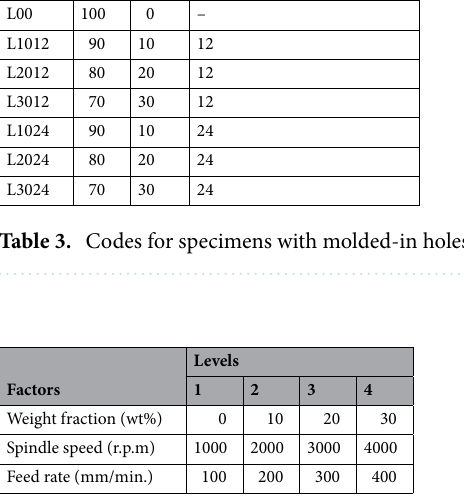
Table 4. Factors of the drilling process and their